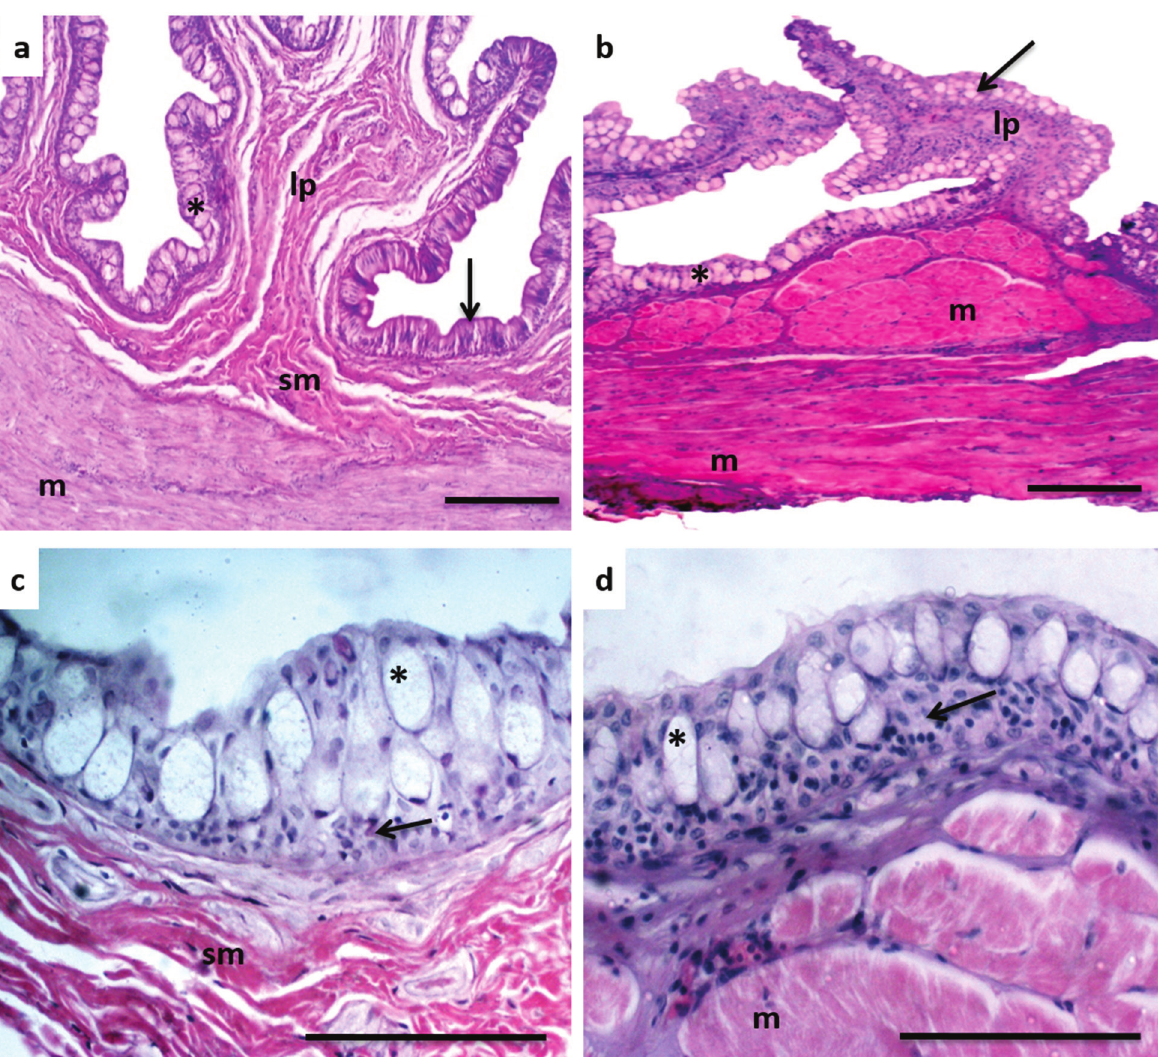
Figure 3 - Stratigraphy of esophagus of Sphoeroides testudineus. - a. Anterior portion of esophagus. HE. - b. Posterior portion of esophagus (abdominal pouch). HE. Bar.: 100 µm. – c. High magnification of anterior esophagus showing the stratified squamous epithelium (arrow). HE. – d. High magnification of posterior portion of esophagus (abdominal pouch) with stratified squamous epithelium (arrow). HE. Bar.: 100 µm. Mucosa rich in globular unicellular mucous glands (*), lamina propria (lp), submucosa (sm), muscular layer